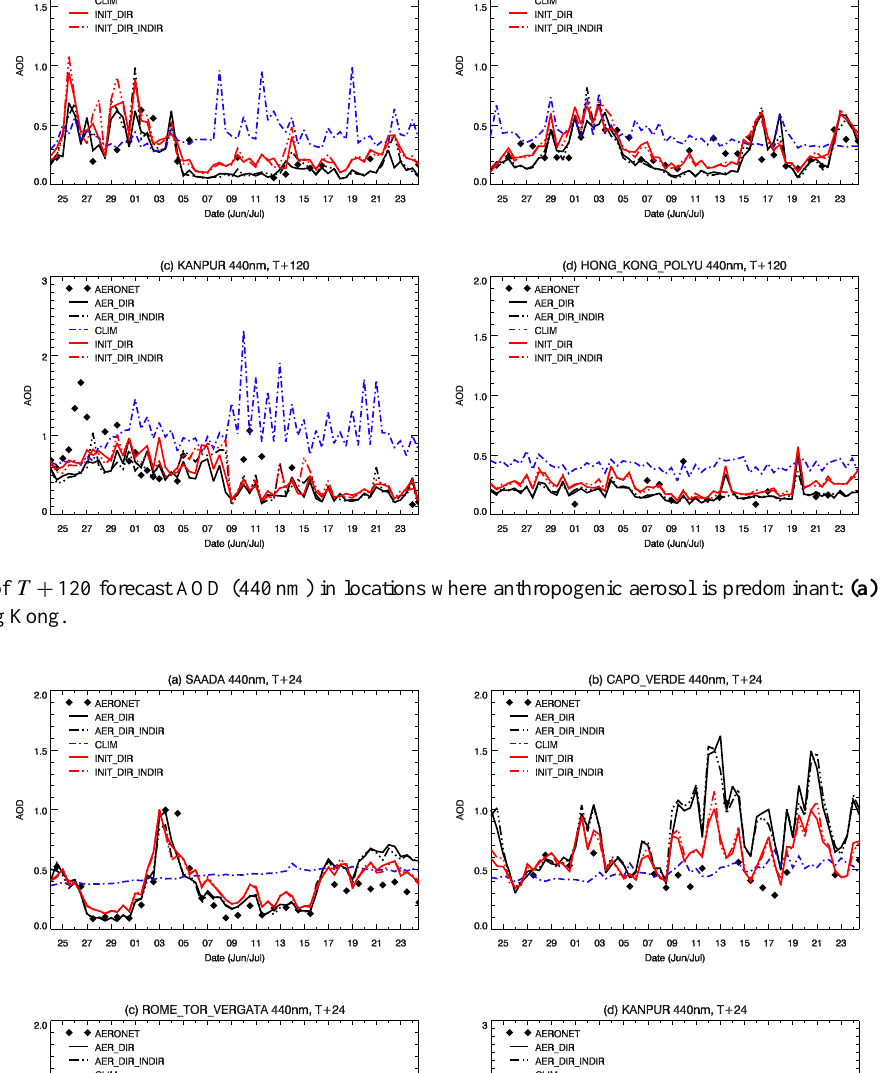
Fig. 5. Time series of T + 24 forecast AOD (440nm) at (a) Saada, (b) Capo Verde, (c) Rome and (d) Kanpur. Fig. 5. Timeseries of T +24 forecast AOD (440 nm ) at (a) Saada, (b) Capo Verde, (c) Rome and (d) Kanpur.